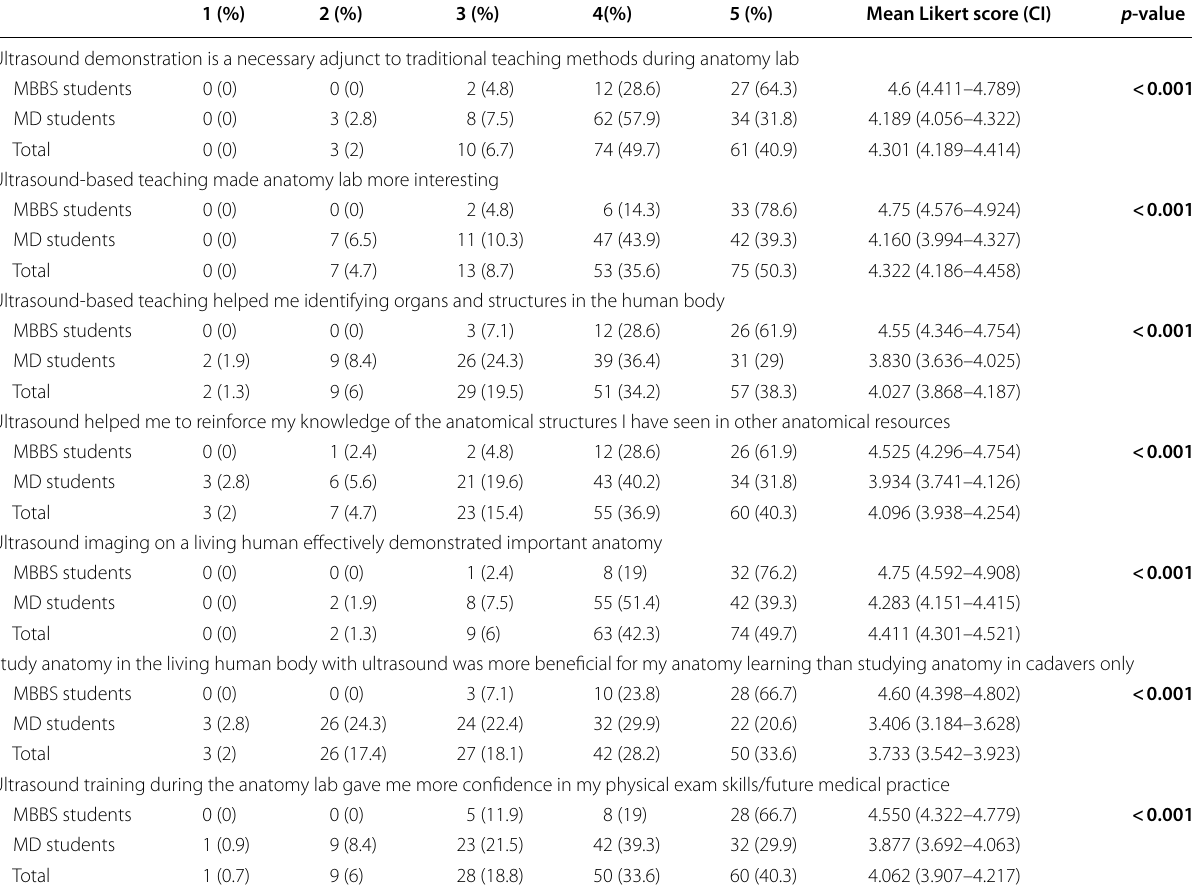
Bold fonts indicate statistical significant values